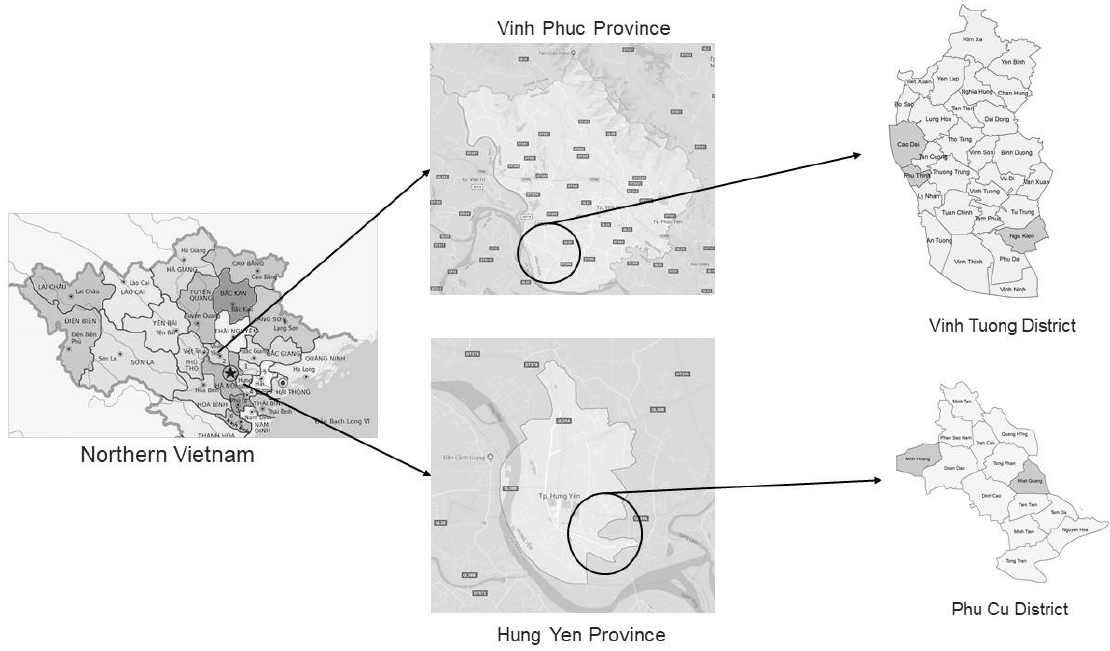
Figure 1. Map of case